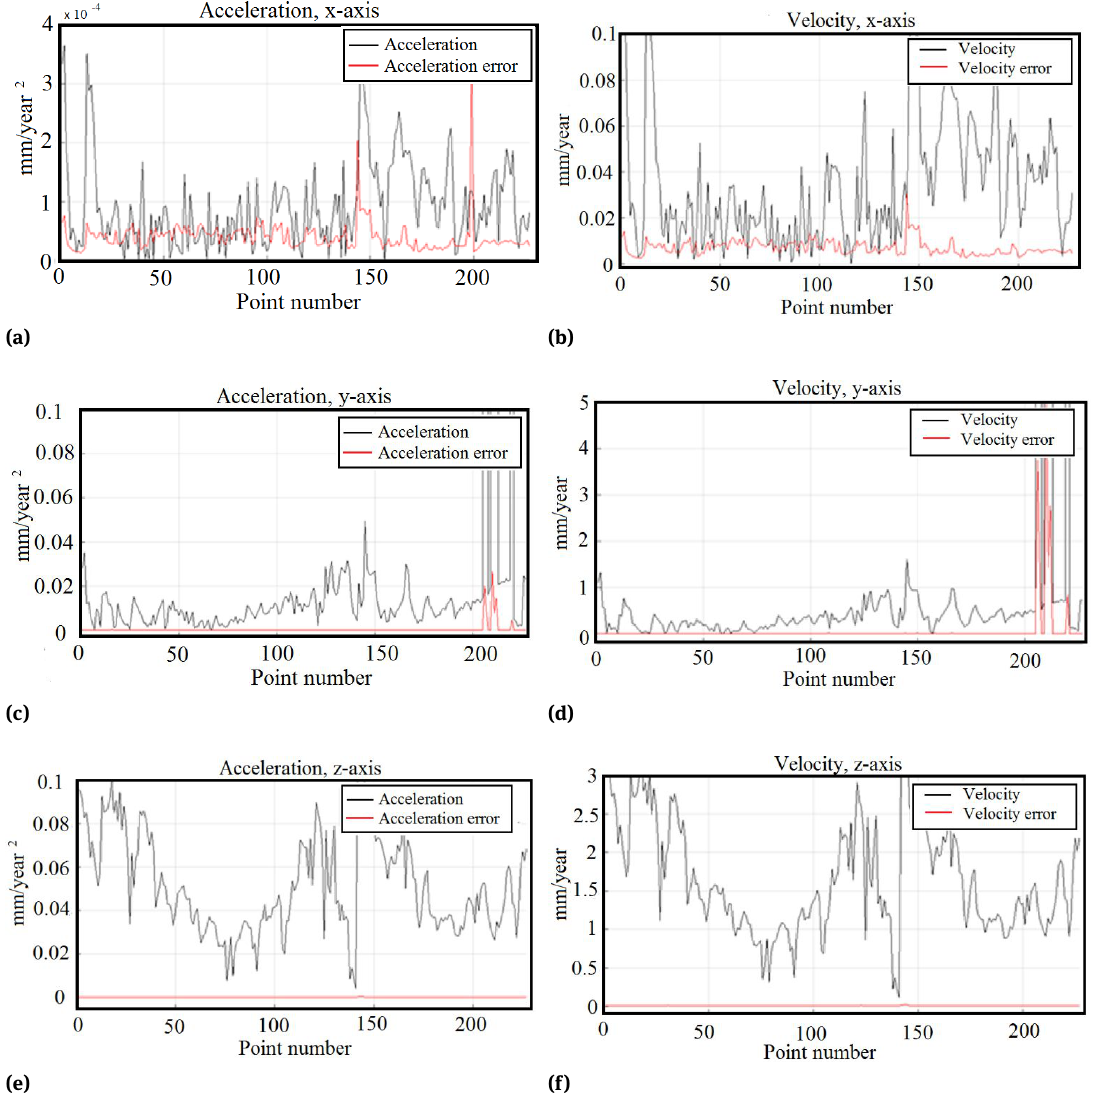
Figure 3: Plot of a) and b) x -coordinate accelerations and velocities and their errors of all points on the hull of the ship, c) and d) y - coordinate acceleration and velocity with their errors, e) and f) those of z